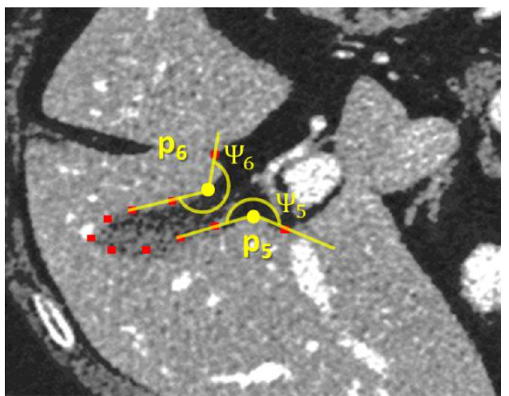
Figure 5. Both vertices have cost function of 0.25, which would be considered as BN by Eq. (9), but their exterior angles are both larger 150° threshold. Therefore, they are correctly excluded from BN